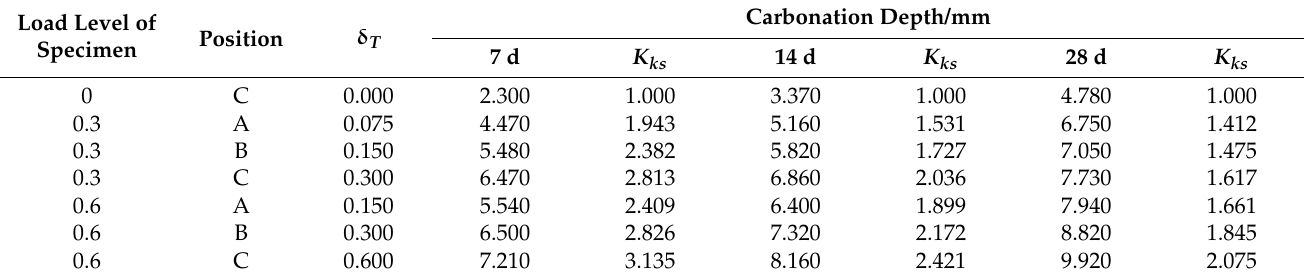
Table 4. Carbonation depths of specimens under different flexural tensile stress